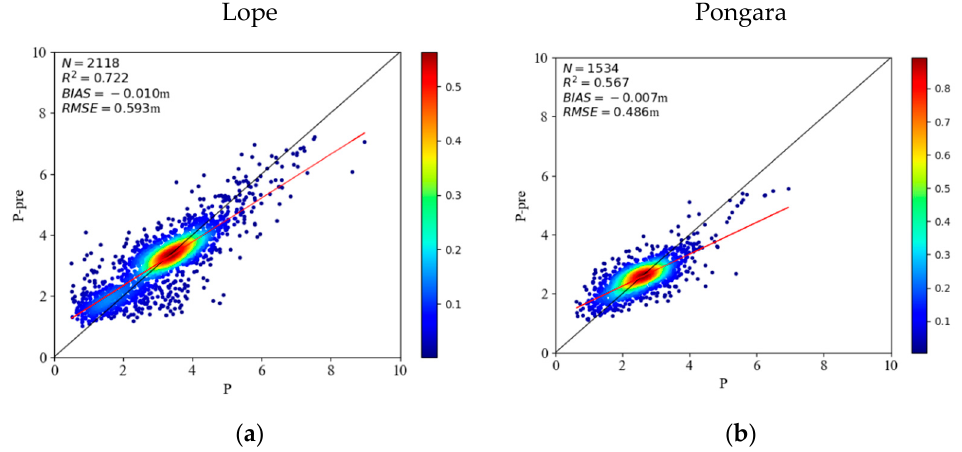
Figure 13. Scatter plots showing the validation results of p -values as correction thresholds for the ( a ) Lope and ( b ) Pongara test areas.